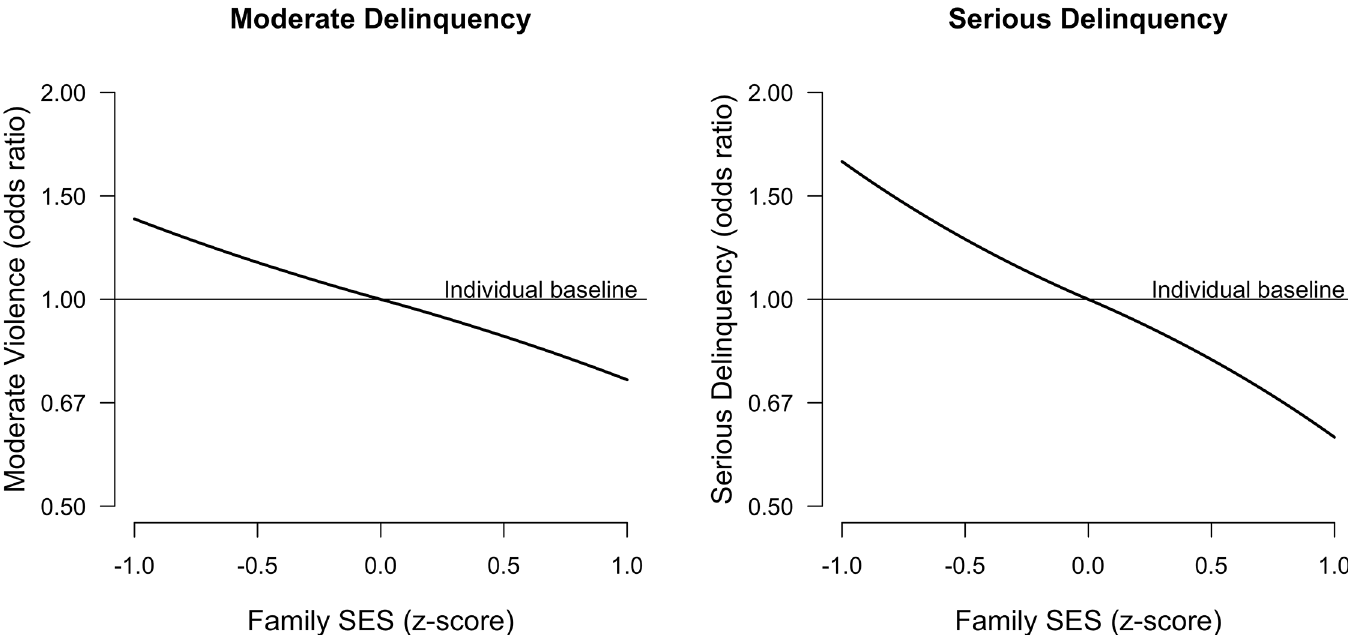
Fig 2. Within Individuals: Relative Odds of Offending as a Function of Family SES. The graph shows that if family SES is at a respondent ’ s individual (across waves) mean, odds of offending are at the respondent ’ s individual baseline. As family SES changes, odds of offending are multiplied with the score on the y-axis.